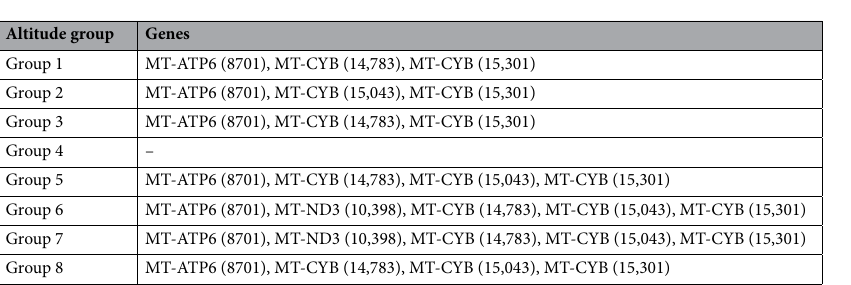
Table 4. Genes corresponding to variable sites co-mutating with global connected nodes of coding